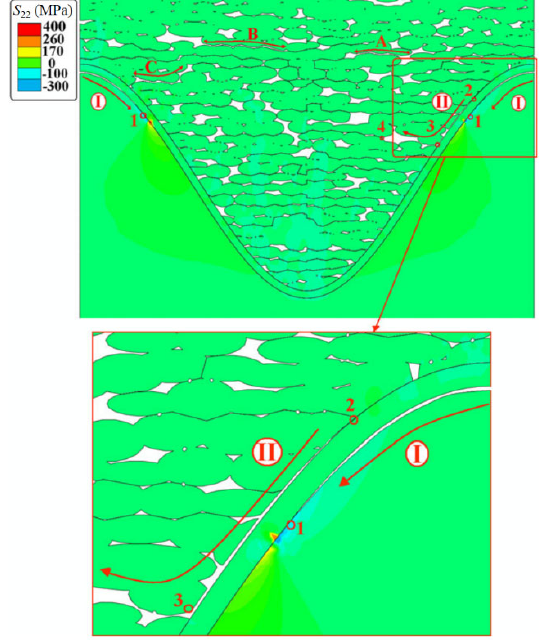
Fig. 27 Crack states in the TC layer at room temperature without considering TGO growth. Reproduced with permission from Ref. [136], © ASM International